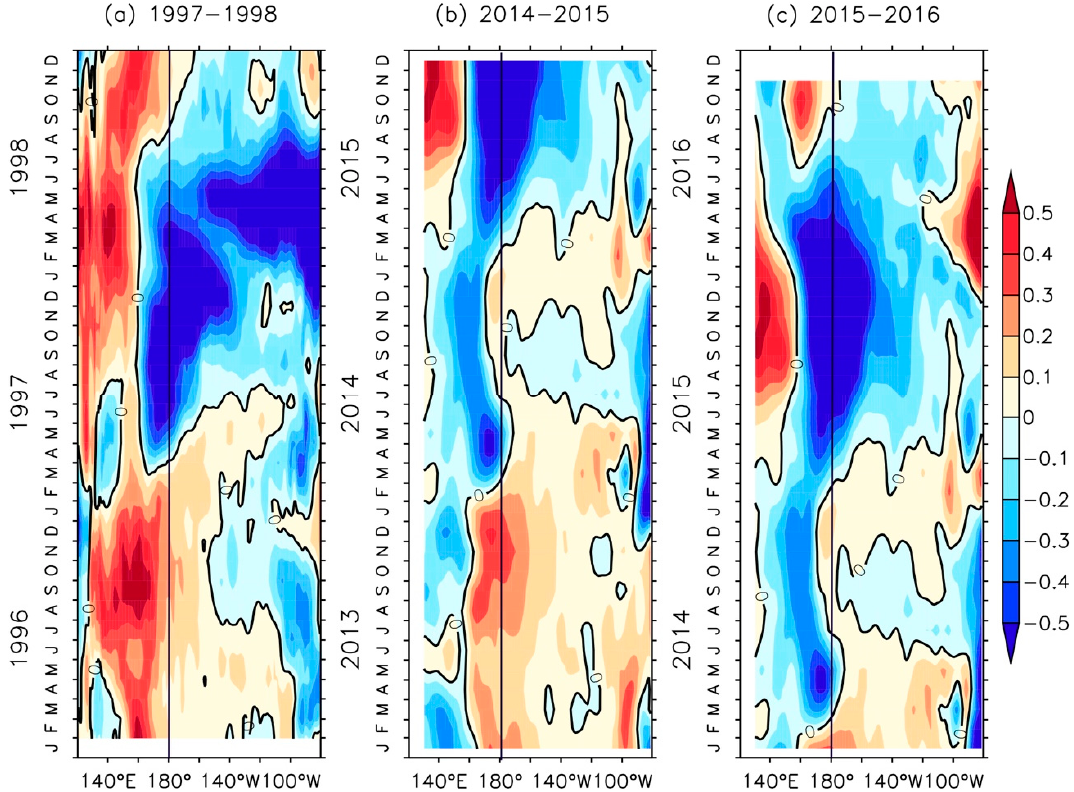
Figure 2. Longitude–time sections of sea surface salinity (SSS) anomaly fields along the equator (averaging over 2° S–2 ° N) during ENs for ( a ) 1997–1998, ( b ) 2014–2015, and ( c ) 2015–2016. The vertical black line represents the location of the international the dateline. The units for SSS are psu.